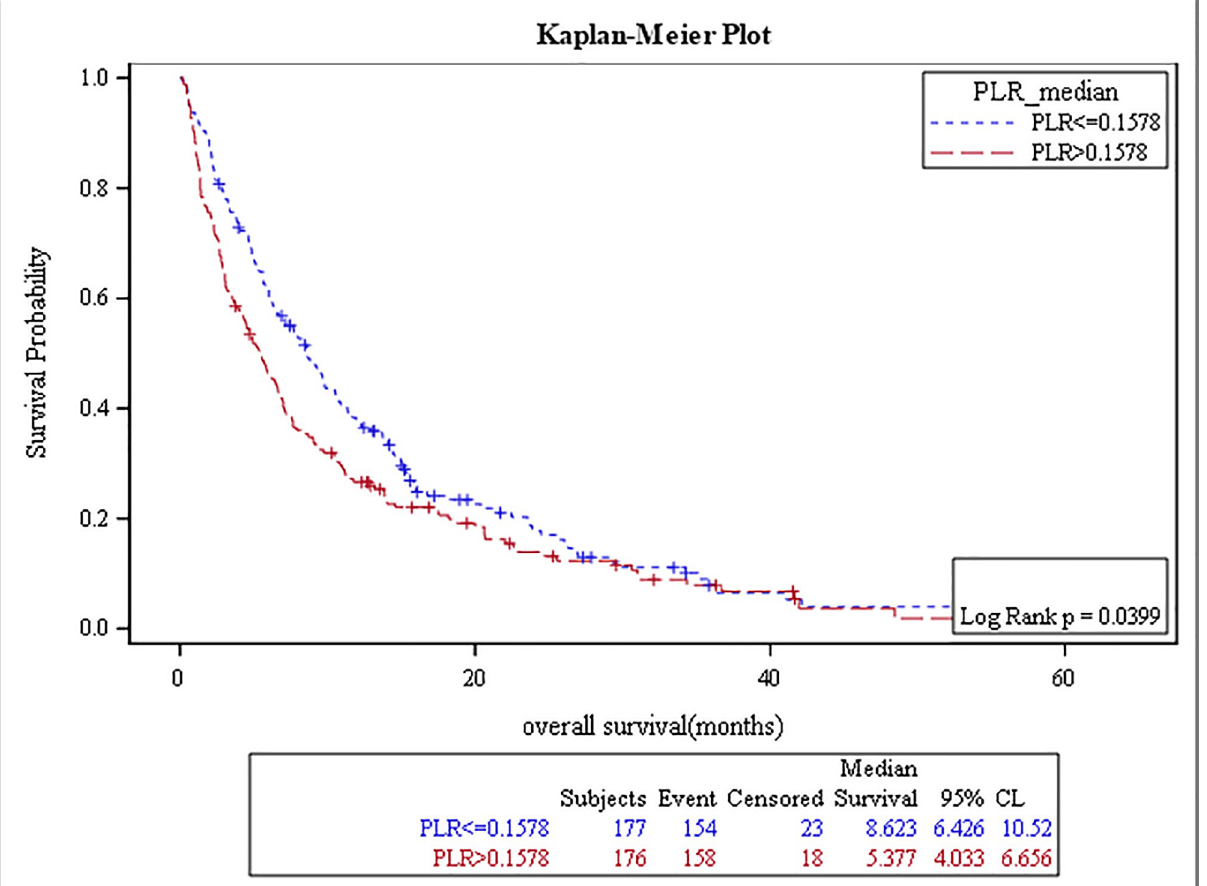
Fig 5. Kaplan Meier curve for overall survival for patients with PLR � 0.15.